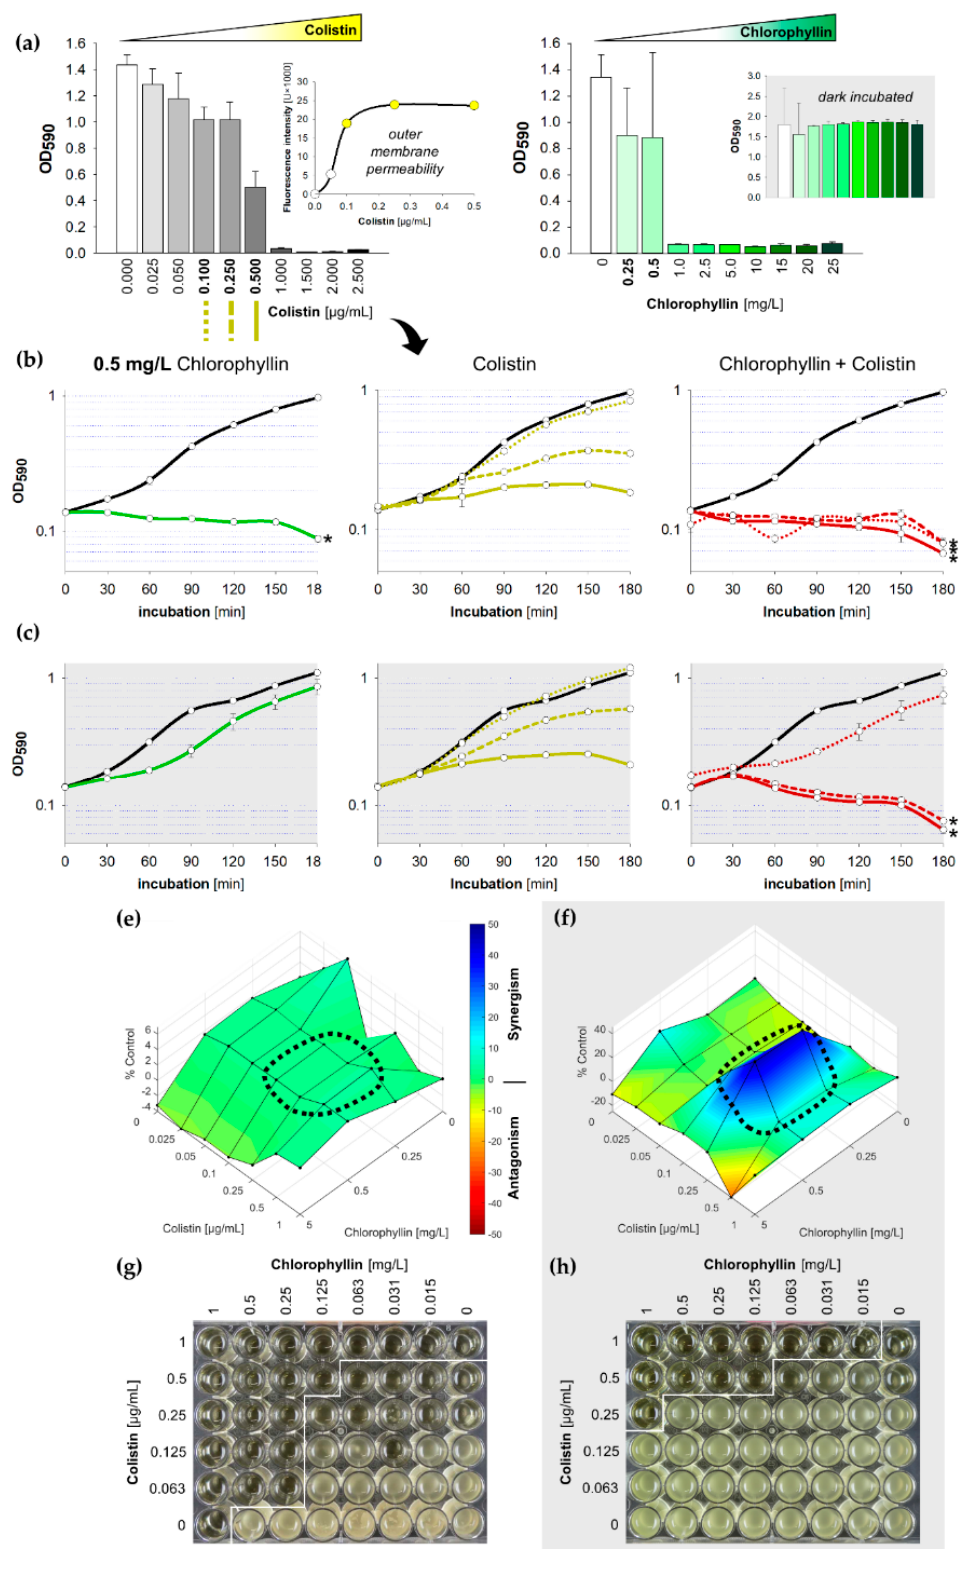
Figure 4. Influence of colistin and chlorophyllin on the growth of Salmonella enterica serovar Typhimurium ; ( a ) Growth status of S. Typhimurium cultures in LB supplemented with different concentrations of colistin (left) and chlorophyllin (right) after 24 h incubation. The outer membrane permeability in the presence of different colistin concentrations was determined by using the 1-N- phenylnaphthylamine (NPN) uptake assay; ( b , c ) growth pattern of S. Typhimurium in the presence of 0.5 mg/L chlorophyllin (green line, first column), colistin (yellow lines, central column) and of a combination of both compounds (red lines, right column). The black lines describe growth in